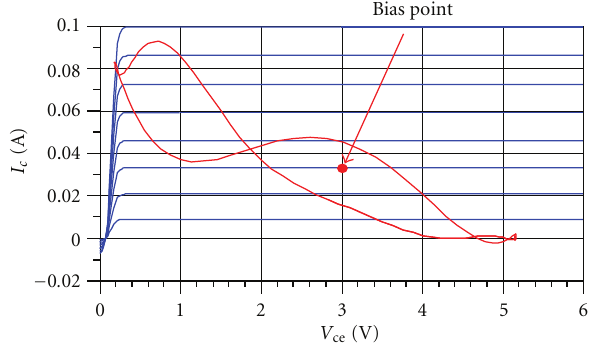
Figure 13: Simulation of amplifier load